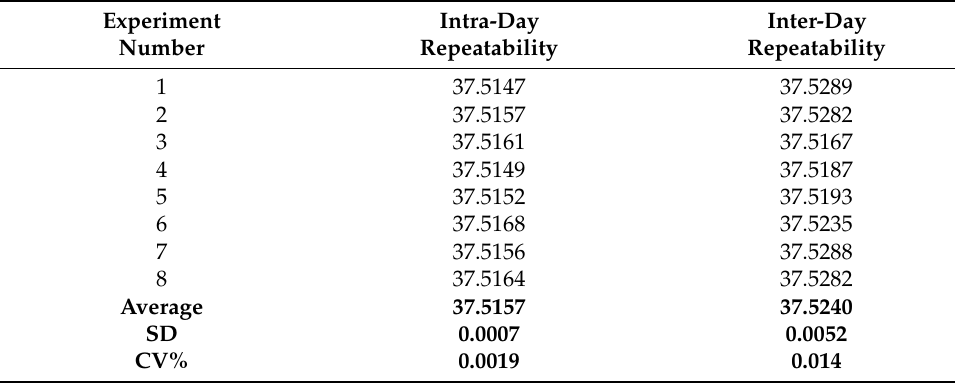
Table 5. The intra-day and inter-day repeatability (average value, SD; coefficient of variation, CV) of the applied method for the determination of Glc concentration in rape honey